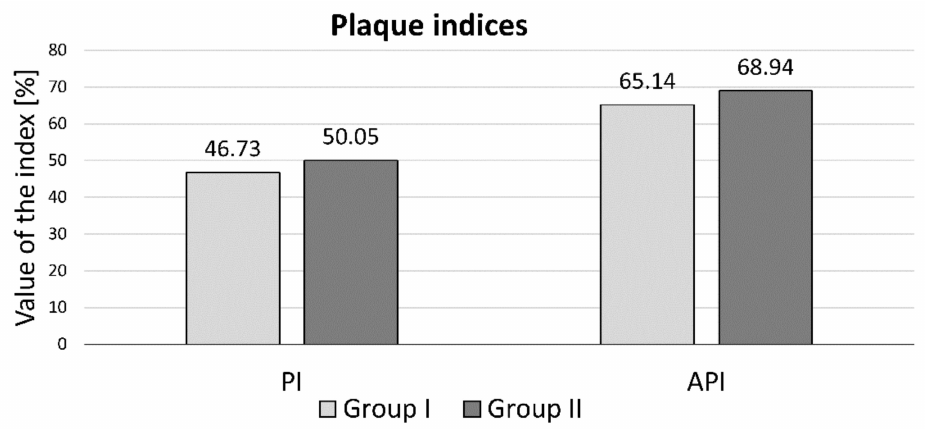
Figure 2. The mean values of the plaque indices in groups I and II.